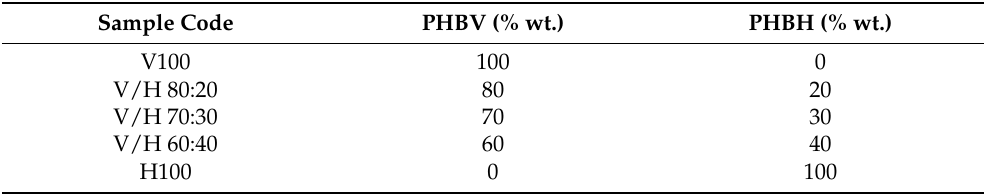
Table 1. Composition and nomenclature of the compositions according to the weight con- tent (% wt.) of poly(3-hydroxybutyrate- co -3-valerate) (PHBV) and poly(3-hydroxybutyrate- co -3- hydroxyhexanoate)